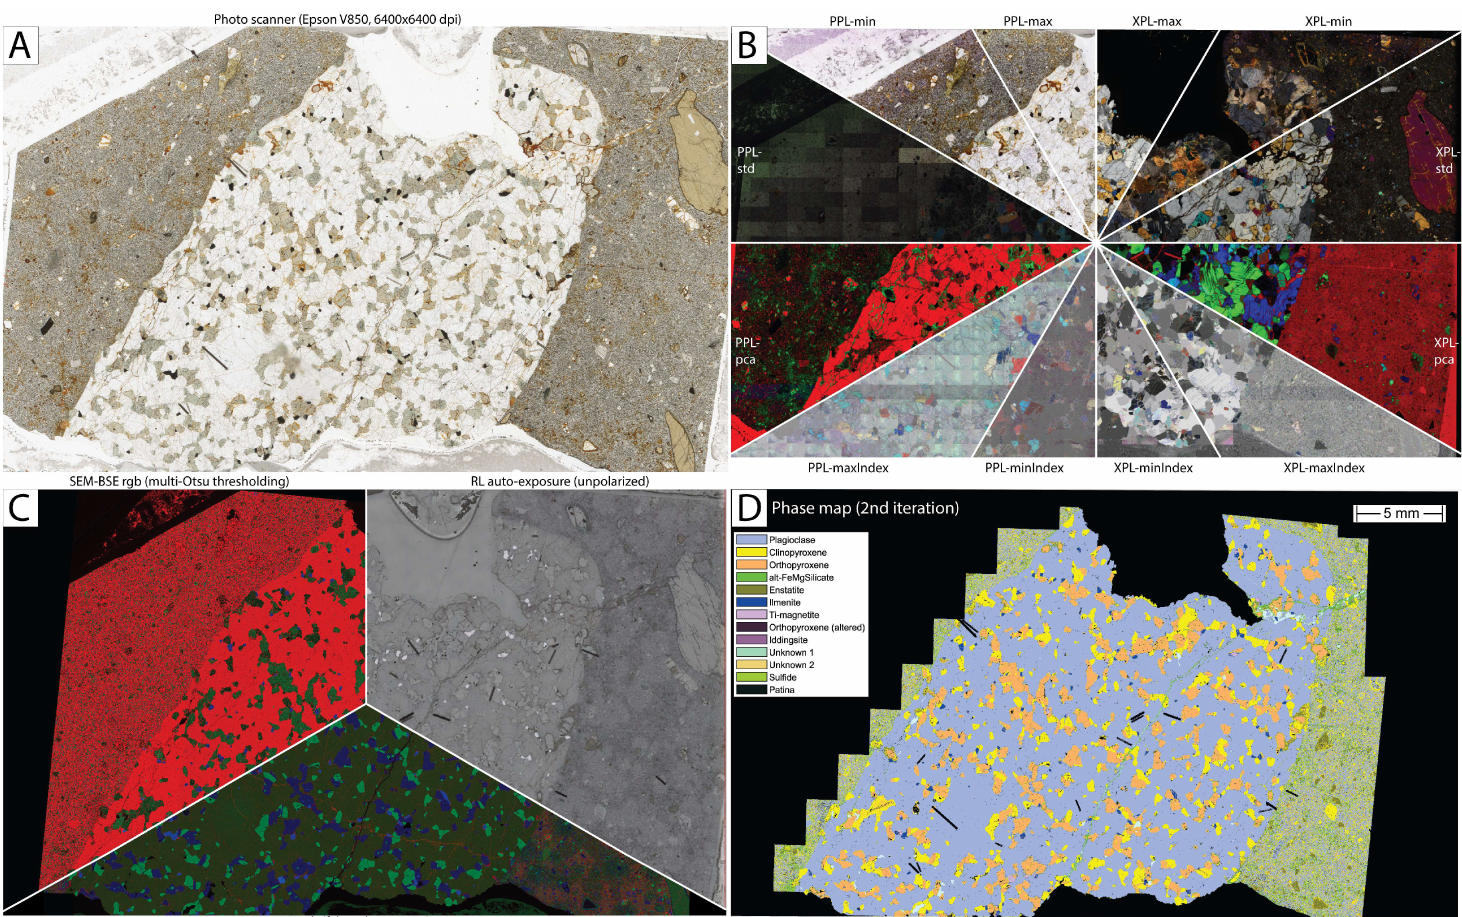
Figure 17. Visual cross-referencing between a regular photo scan ( A ), ray tracing products ( B ), and electron microscopy ( C ) and a phase map (iteration #2) with a colour legend ( D ). Iteration #2 incorporated recoloured SEM-BSE and the -EDX ‘TruMap’ stack (27 characteristic X-ray lines) principal component analysis (PCA) to the ray tracing stack for improving segmentation accuracy. This has helped resolve the distinction between pyroxenes within the xenolith. The output map intersects have defined a smaller sample area (15 selectable channels, evidencing areas filled with alteration minerals, fracturing, epoxy, and prior laser ablation grooves). Pyroxene-plagioclase granulite xenolith